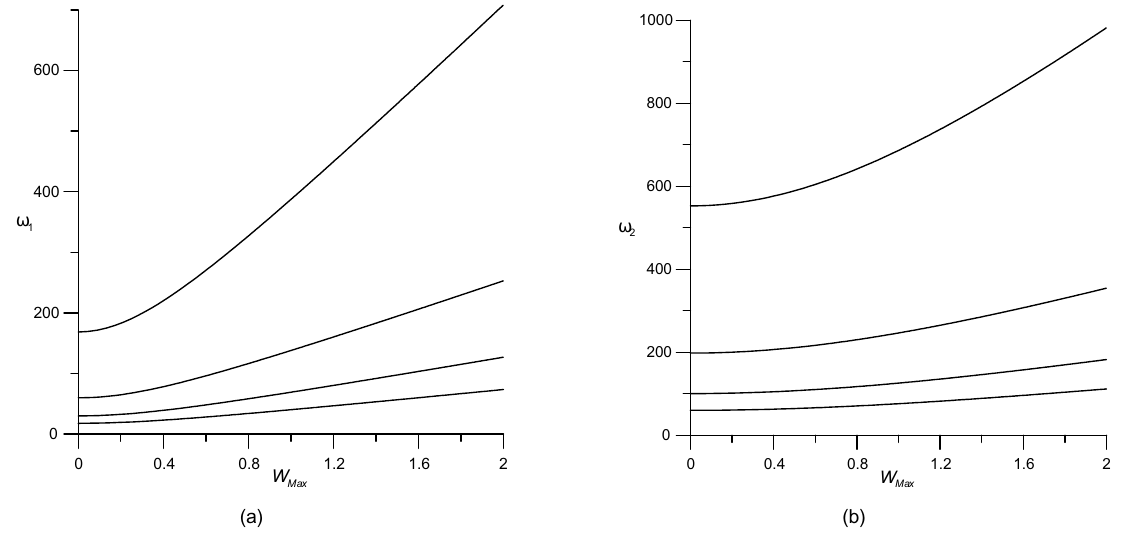
Fig. 11. The first (a) and second (b) natural frequencies of the plate as functions of the maximum nondimensional deflection W Max for sliding-clamped plates of inner radii b = 0 . 1 , 0 . 3 , 0 . 5 , and 0 . 7